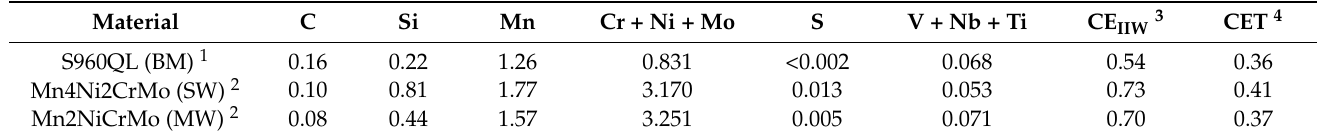
Table 1. Chemical composition in wt.% of test materials (Fe—balance).